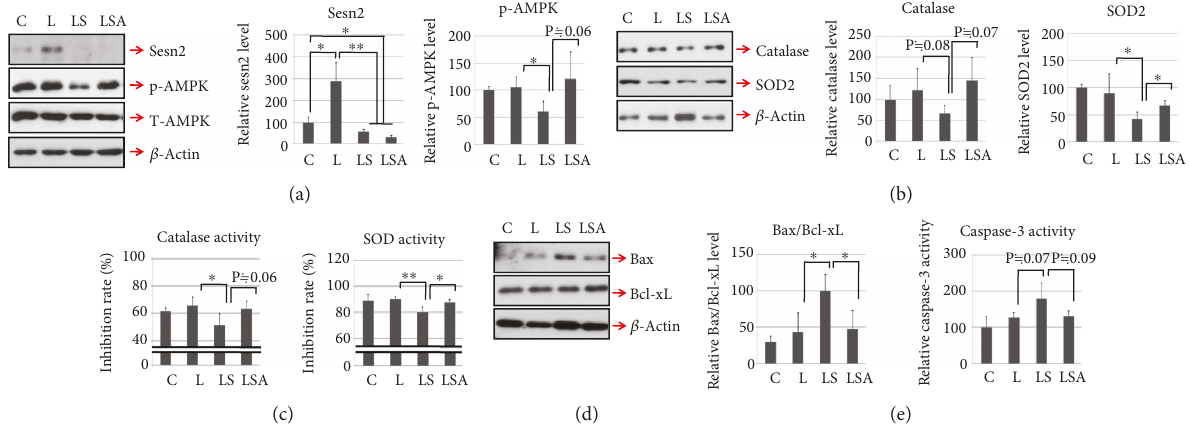
Figure 4: Sesn2 knockdown increases LPS-mediated cell death signaling in C57BL/6 mice. (a) To assess sens2 knockdown e ffi ciency in heart tissue, Western blotting was used to measure the protein levels of sesn2 and phosphorylated AMPK. (b) The levels of catalase and SOD2 were determined by Western blotting. (c) The activities of catalase and SOD were measured using commercial assay kit. (d) The ratio of Bax to Bcl- xL was detected by Western blotting. (e) Caspase-3 activity in heart tissue was measured using a Caspase-3 Activity Assay Kit. All graphs present data from four mice per group (C: control mice; L: LPS only-treated mice; LS: sesn2 siRNA plus LPS-treated mice; LSA: sesn2 siRNA plus LPS and AICAR-treated mice). Data are presented as means; error bars represent ± SD ( ∗ P < 0 05 ; ∗∗ P < 0 005 ; ANOVA).